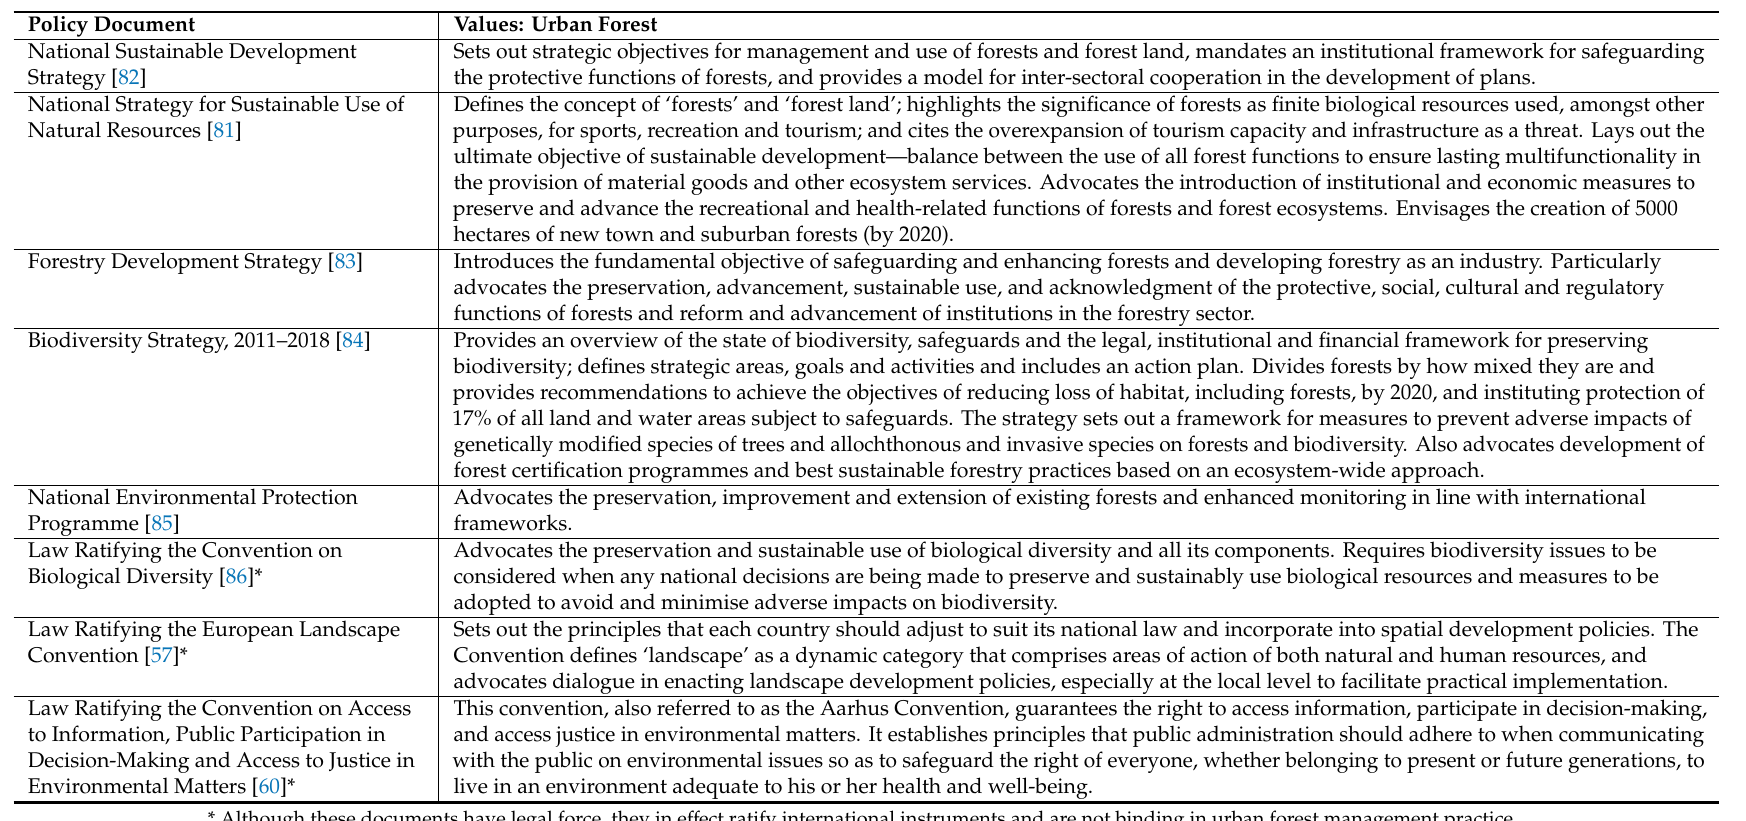
Table 2. The value framework for urban forest protection in